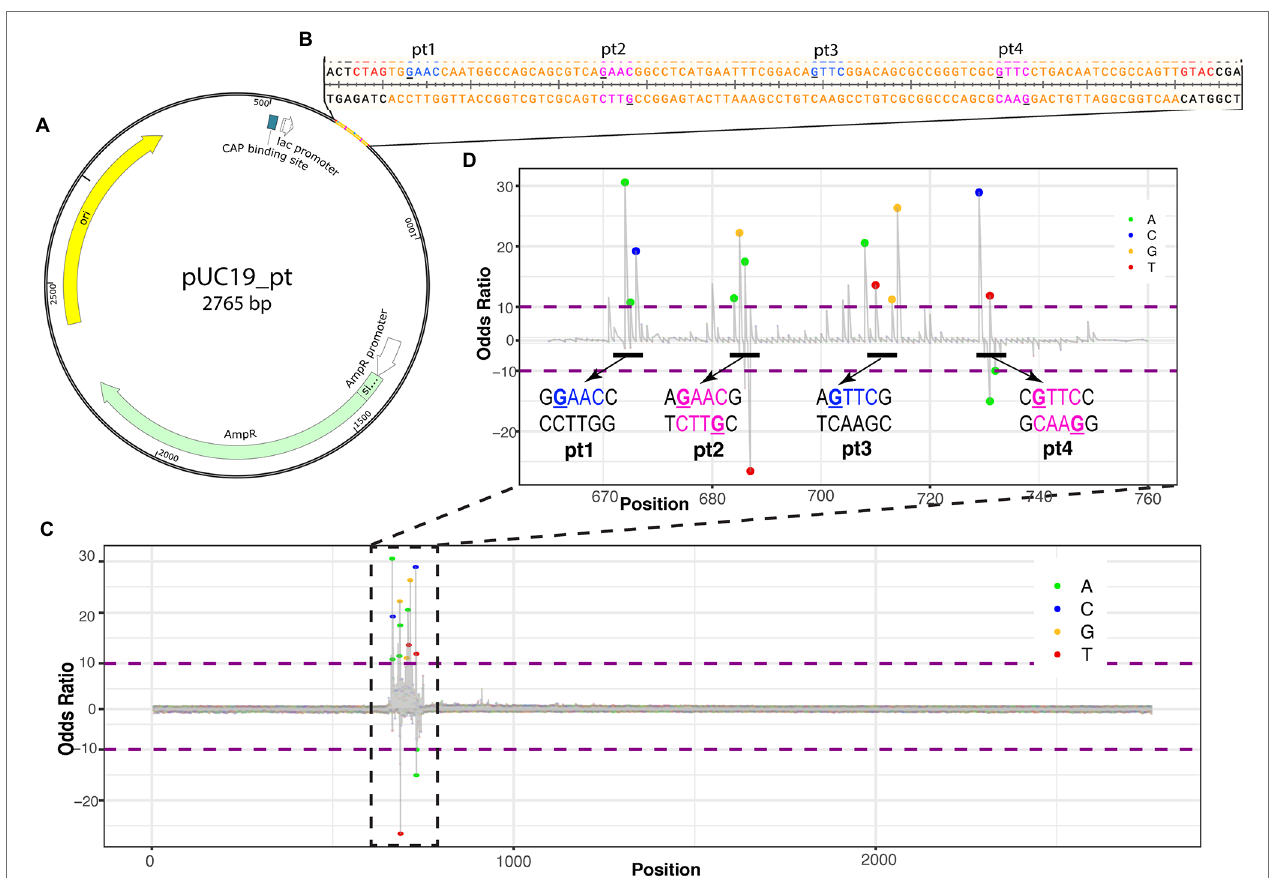
FIGURE 1 | Identifying PT modifications in the pUC19 plasmid. (A) Schematic of pUC19_pt plasmid with genes (AmpR in green, origin in yellow, and CAP binding site in white) and 2 ′ deoxyoligonucleotide with PT modifications insert. (B) Nucleotide sequence for insert (in orange). PT modification sites were added at the underlined guanines of the insert. Blue nucleotides are single-stranded PT modifications; magenta nucleotides are double-stranded PT modifications. Red nucleotides are the sticky ends that ligate into Xbal and Kpn1 cut sites of the plasmid and are included on the insert. (C) ELIGOS-determined odds ratio at each base within the plasmid showing the highest odds ratios at the insert. (D) Odds ratio of the insert showing spikes around the manufactured PT modifications. The bases within the odds ratio range from 10 to − 10 are identified with a dot color coded to each base (see color key in top right corner of the panel). The dots will be shown when adjusted to value of p <